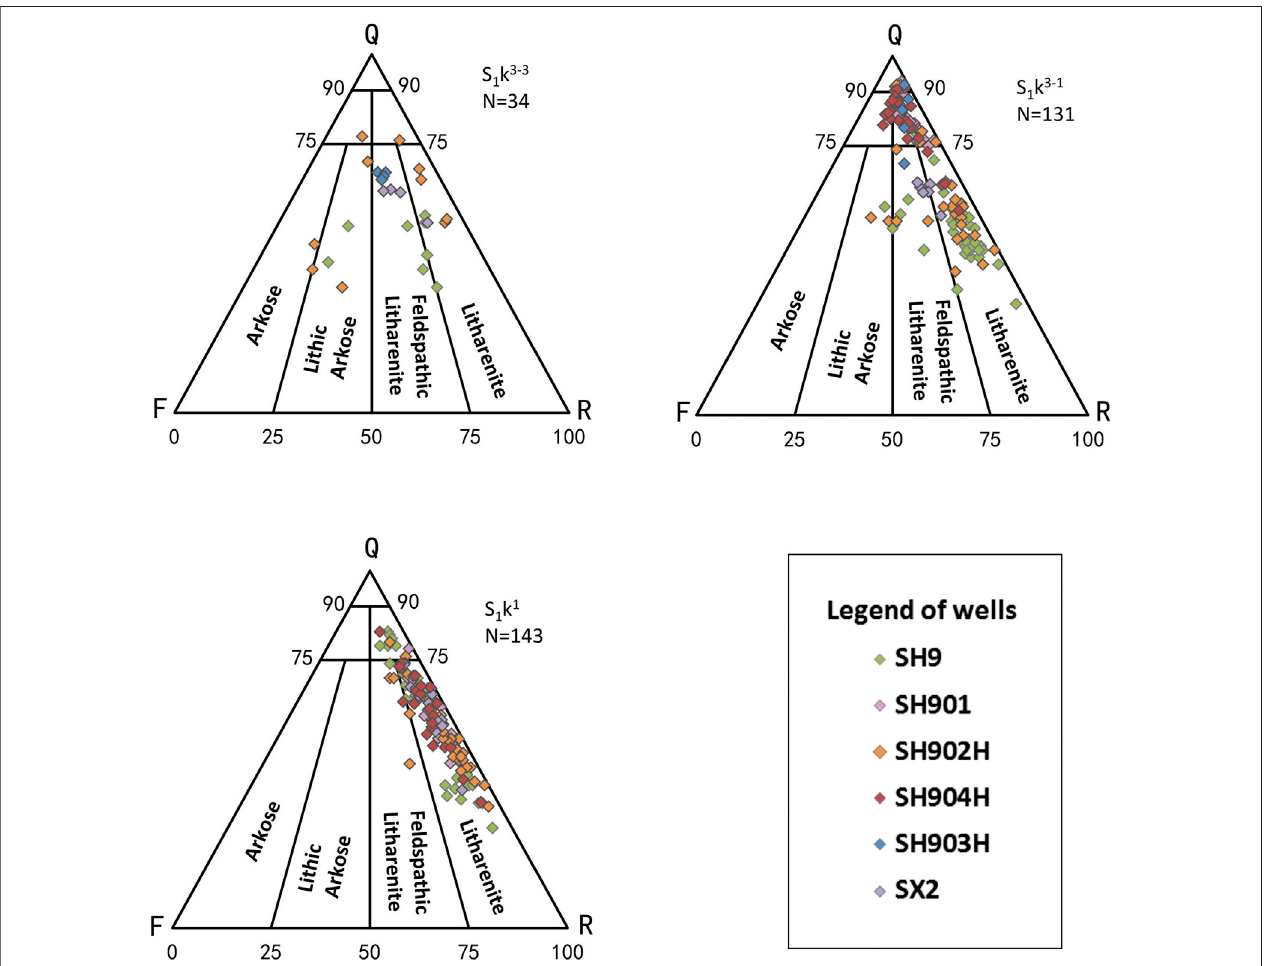
FIGURE 2 | Composition determined from thin-section analysis (a. S 1 k 3-3 . B . S 1 k 3-1 . C . S 1 k 1 .). (Q — Quartz + Chert; F — Feldspar; R — Rock fragments) (ternary diagram from Zhao and Zhu, 2006).